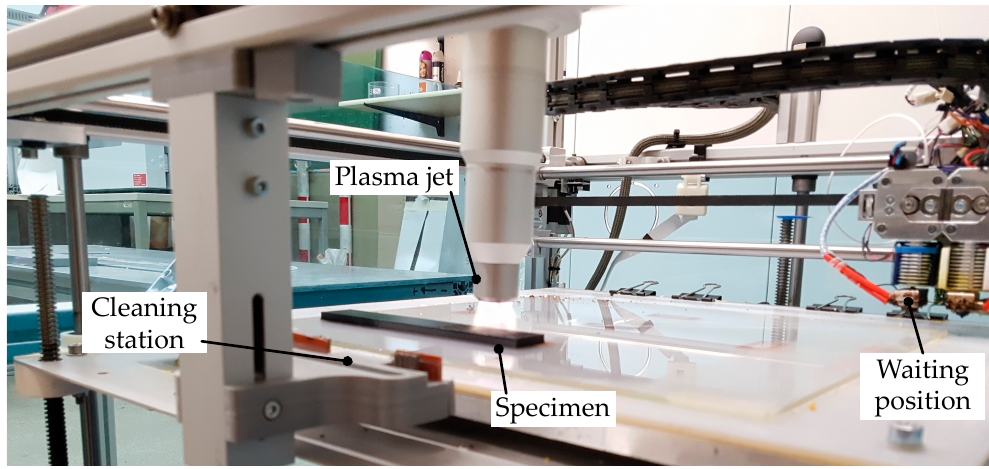
Figure 7. Robot-based plasma pretreatment of the lower part of the specimen before applying of the second material.